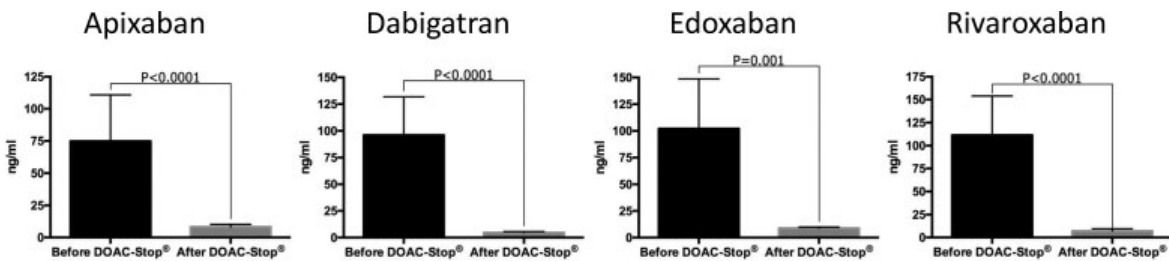
Fig.1 Impactof the DOAC-Stop ® adsorbent treatmenton apixaban, dabigatran, edoxaban, and rivaroxaban concentrations. The mean (and 95% con fi dence interval) of each direct oral anticoagulant is presented before and after the DOAC-Stop ®